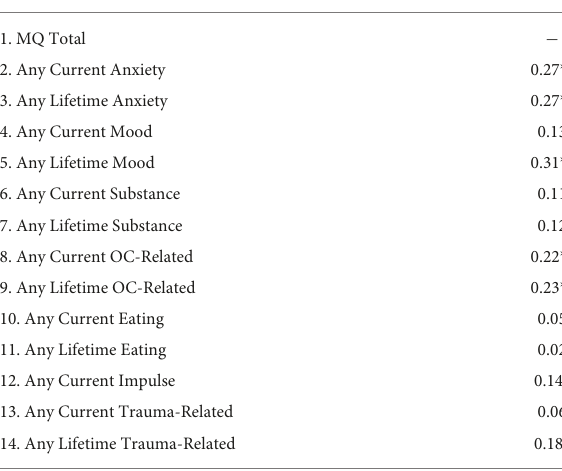
TABLE 2 Correlations between total score on the Misophonia Questionnaire (MQ) and categories of current and lifetime DSM-5 psychiatric diagnoses.